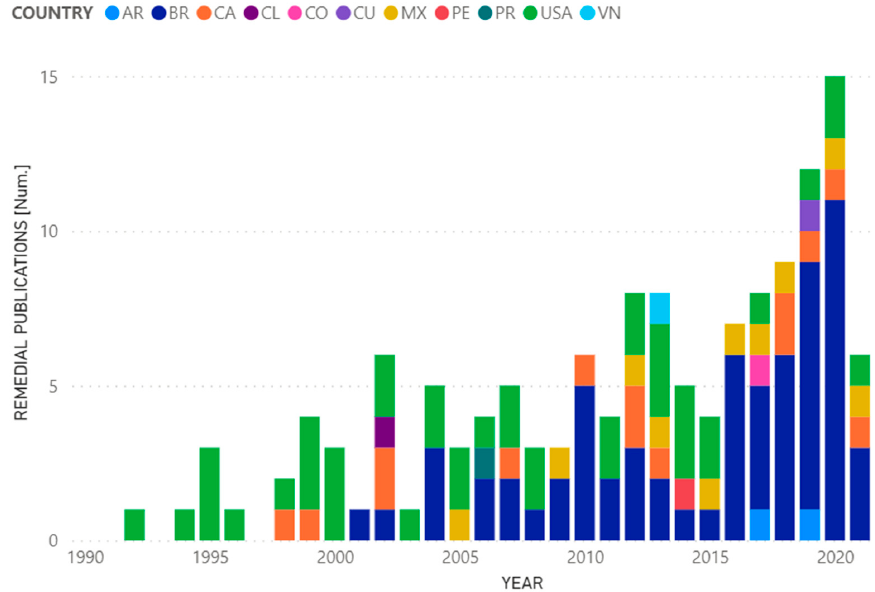
Figure 10. Remedial publications by years and